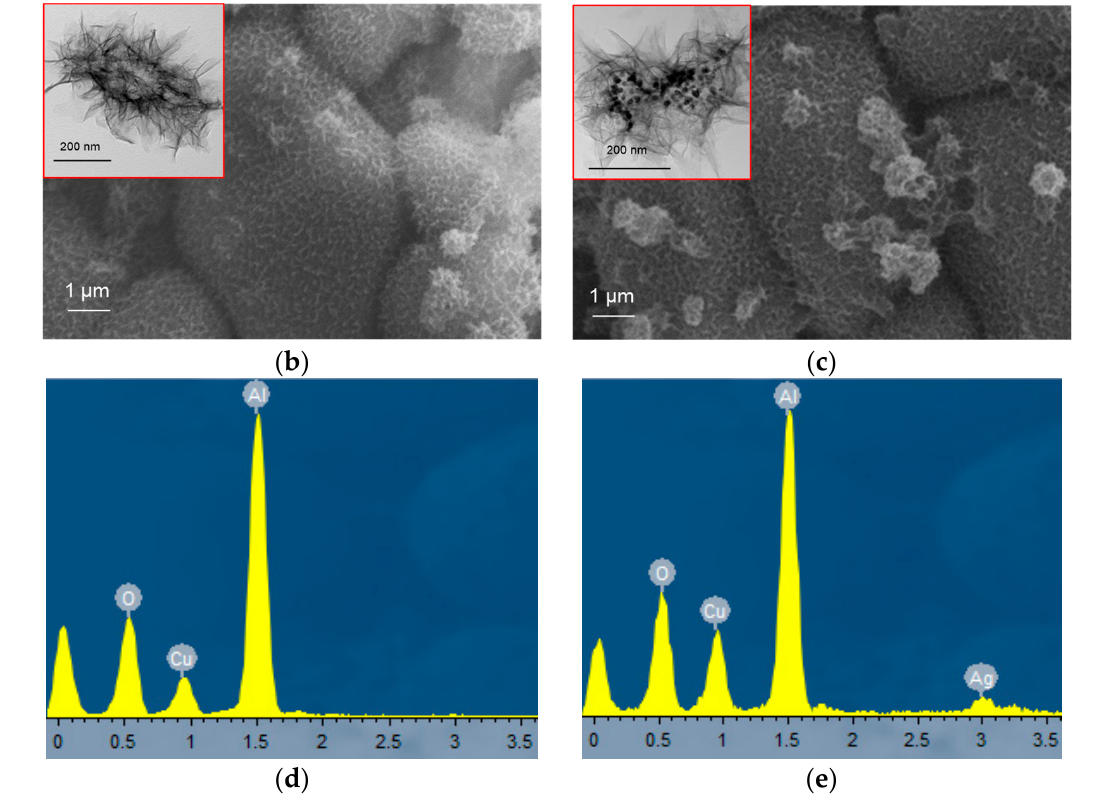
Figure 5. SEM images of macroporous alumina ceramic before ( a ) and after modification with AlOOH ( b ) and AlOOH/Ag ( c ) nanostructures; EDX spectra of the ceramics surface after the modification with AlOOH ( d ) and и AlOOH/Ag ( e ) nanostructures. Insets in ( b , c ) images show nanostructures formed by water oxidation of Al and Al/Ag nanoparticles under similar